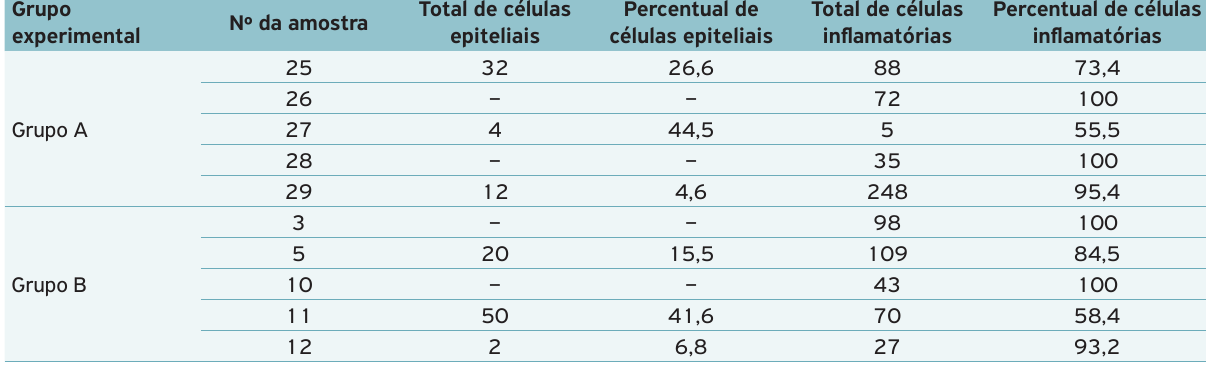
Tabela 2. Valores absolutos e percentuais do número de células epiteliais e infl amatórias observadas em cada amostra de lavado